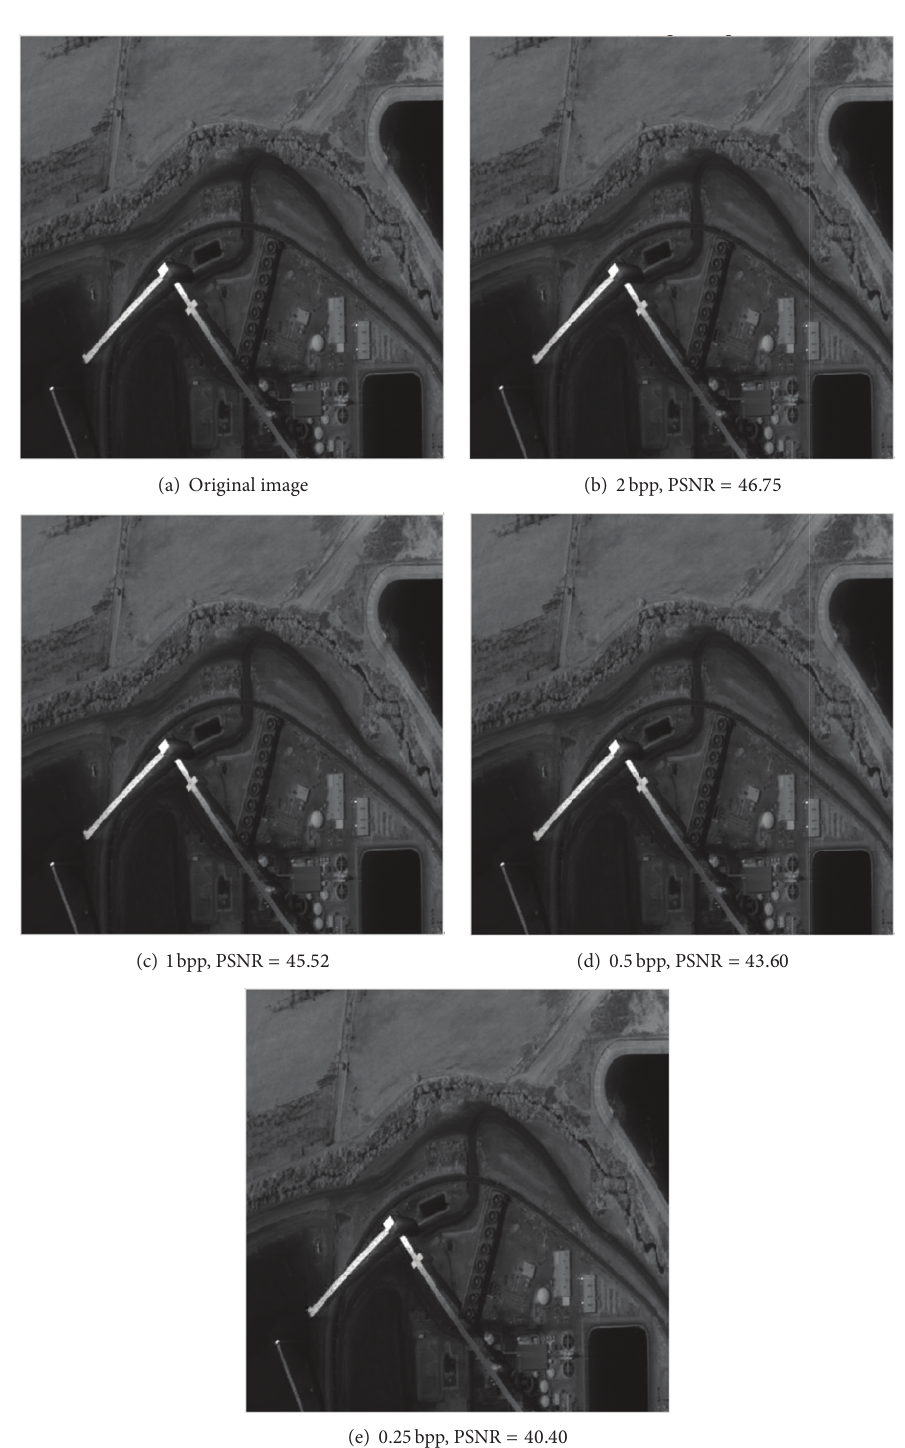
Figure 20: Reconstructed remote image at different bit